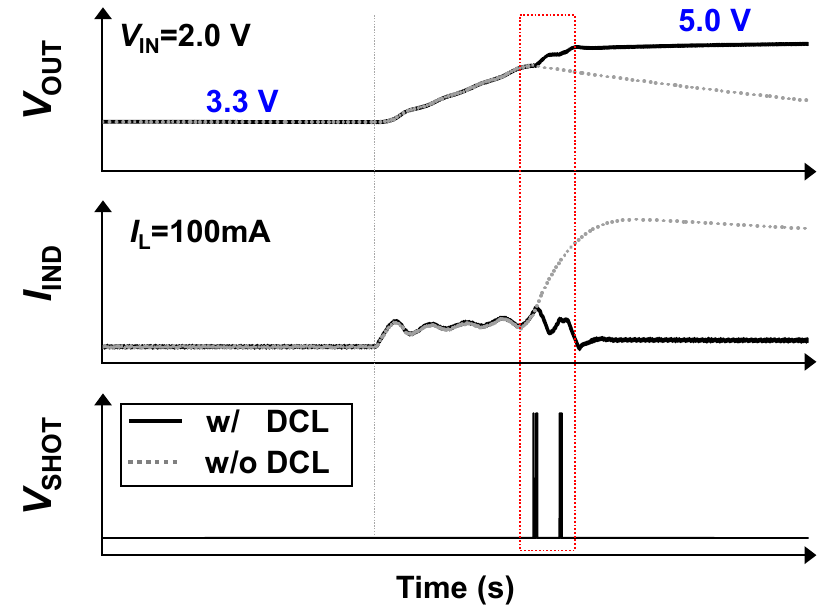
Figure 5. Dynamic output voltage scaling according to the duty cycle limiter (DCL) scheme.